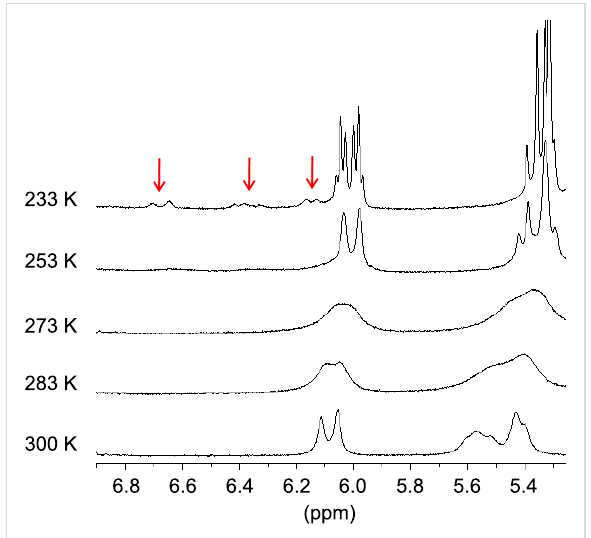
Figure 3: Vinylic region of the low temperatures 1 H NMR spectra of 6a in CDCl 3